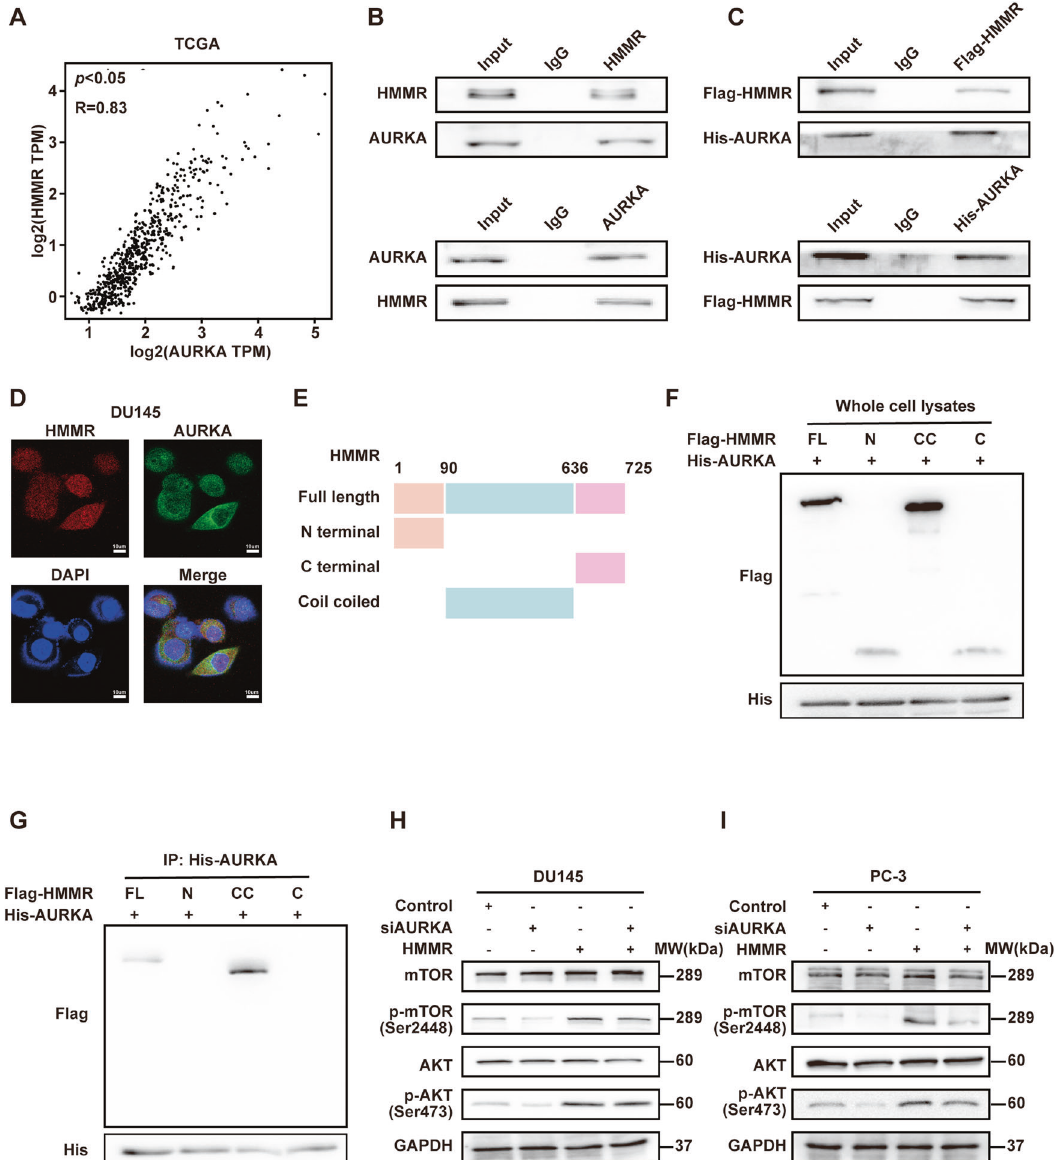
Fig. 4 HMMR interacted with AURKA to mediate mTORC2/AKT pathway. A Correlation of HMMR and AURKA in PCa was analysed by GEPIA ( R = 0.83, p < 0.05). B Co-IP analysis of the interaction of endogenous HMMR and AURKA with anti-HMMR (upper) or anti-AURKA (lower) antibodies. C Co-IP analysis of the interaction of Flag-labelled HMMR and His-labelled AURKA with anti-Flag (upper) or anti-His (lower), respectively. D Immuno fl uorescence was performed to analyse the relationship between HMMR and AURKA and their localisation in DU145 cells. The nucleus was stained with DAPI, scale bar: 10 μ m. E Diagrammatic drawing of a series of HMMR deletion mutation plasmids. F , G Co-IP analysis of His-AURKA interacting with the detailed domain of Flag-HMMR. His-AURKA was co-transfected with HMMR deletion mutants in HEK-293T cells, and whole-cell lysates were immunoprecipitated with anti-His antibody and blotted with anti-Flag antibody. H , I Western blotting analysis of mTORC2/AKT pathway after transfection with AURKA-speci fi c siRNA and/or HMMR plasmid in DU145 ( H ) and PC-3 ( I )